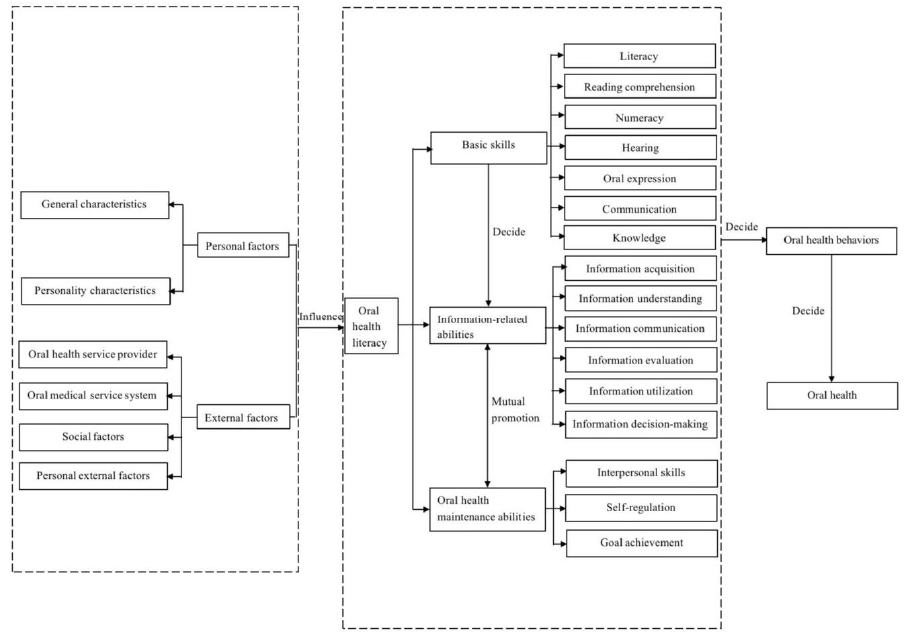
Figure 3. OHL conceptual